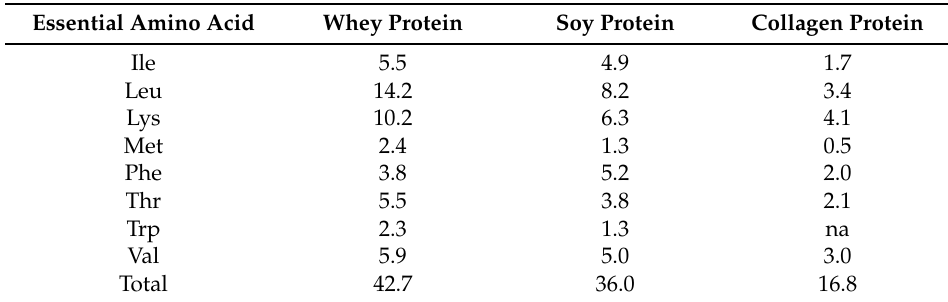
Table 4. Approximate essential amino acid profile of various protein sources [27]. Essential Amino Acid Whey Protein Soy Protein Collagen Protein Ile 5.5 Leu